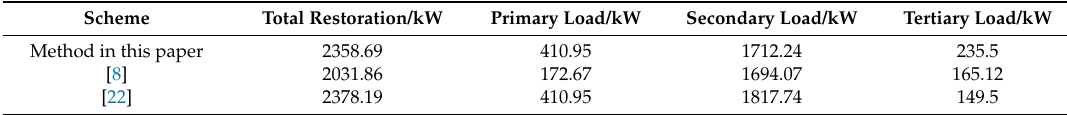
Table 6. Comparison of island partition load restoration results.